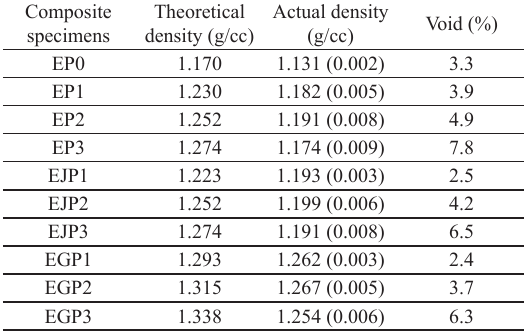
Table 2. Theoretical density, actual density, & void content of EP composites, EJP, and EGP hybrid composites. Composite